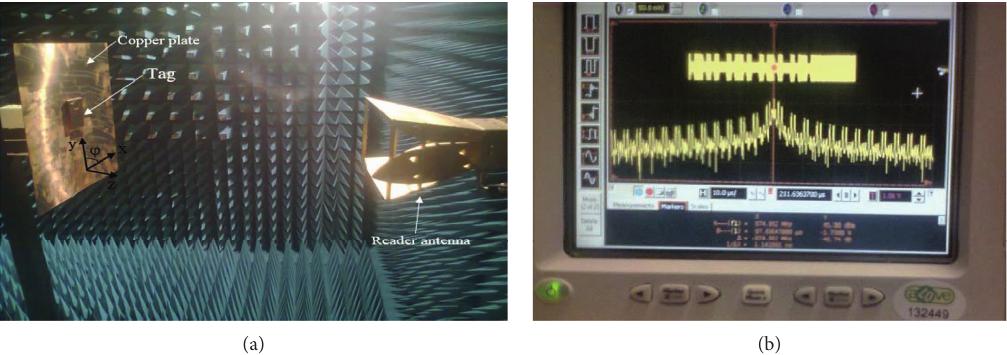
Figure 7: Tag measurement setup in the anechoic chamber for tag sensitivity measurements. (a) PILA tag range measurement. (b) Portion of the received tag response at